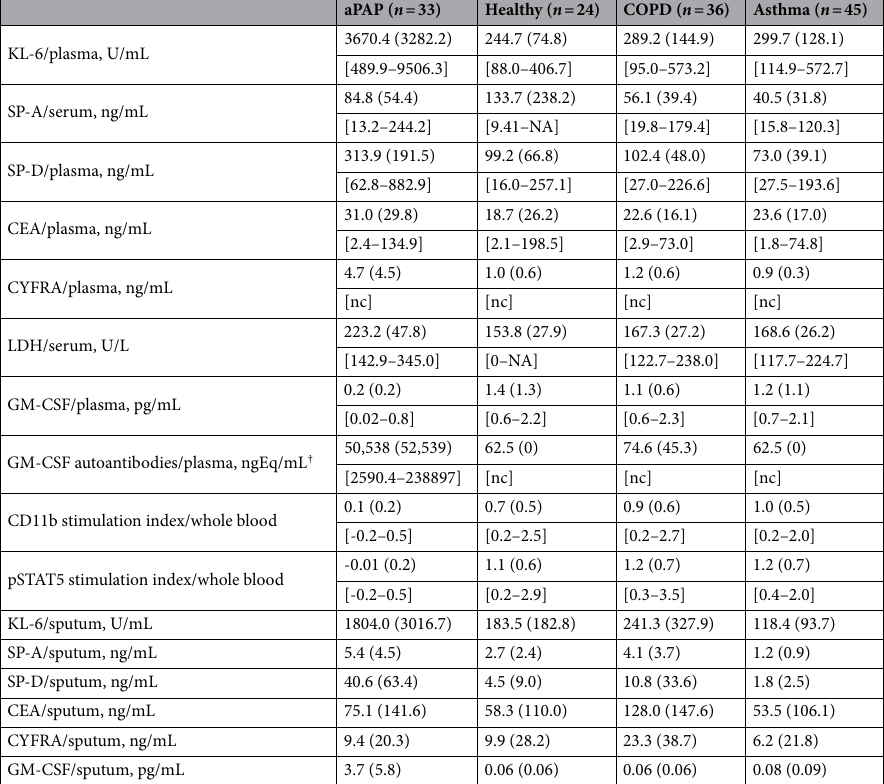
Table 2. Absolute values for biomarkers at baseline (per-protocol biomarker analysis, mean (SD) [95% reference interval]*). Numbers of patients assessed differ slightly for some biomarkers. *Calculation based on the robust method in the Clinical and Laboratory Standards Institute guideline 36 . † Concentrations of GM-CSF autoantibodies were BLQ for all healthy volunteers, all patients with asthma and most with COPD. All these concentrations were therefore set to 0.5 LLQ, yielding mean plasma concentrations of 62.5 ngeq/mL for healthy volunteers and patients with asthma. aPAP autoimmune pulmonary alveolar proteinosis, BLQ below the limit of quantification, CD11b cluster of differentiation molecule 11b, CEA carcinoembryonic antigen, CI